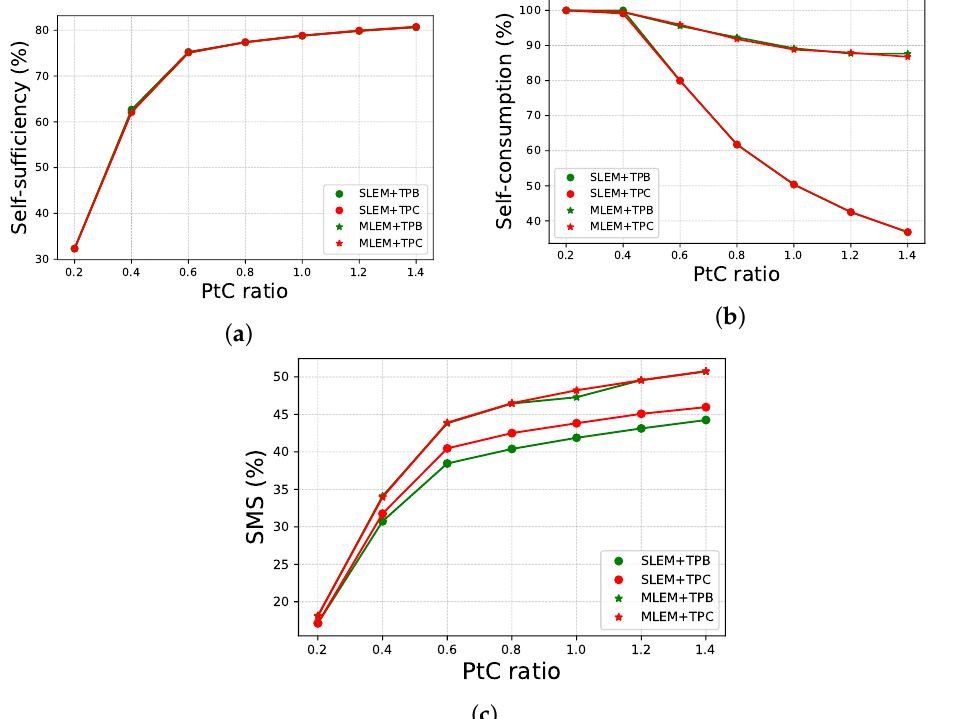
Figure 8. ( a ) Community self-sufficiency, ( b ) self-consumption, and ( c ) share of market savings for varying PtC ratios.